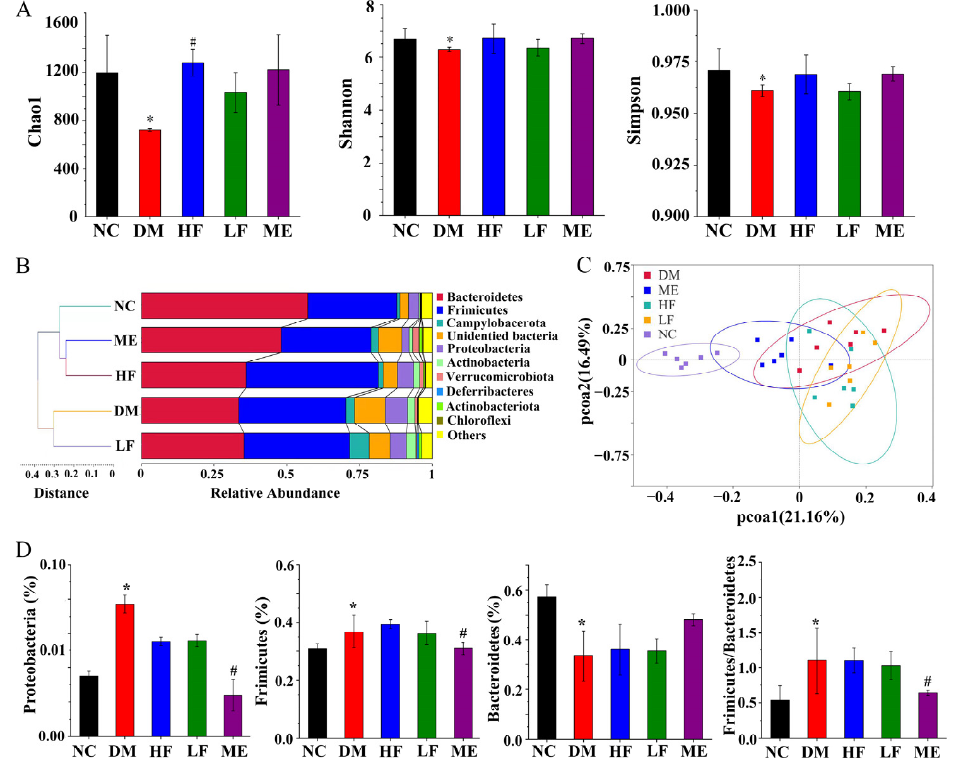
Figure 6. Effect of LJF on the gut microbiota: Chao1, Shannon, and Simpson indexes ( A ); UPGMA ( B ); PCoA ( C ); relative abundances of Proteobacteria, Firmicutes, Bacteroidetes, and the ratio of Firmicutes to Bacteroidetes at the phylum level ( D ). * p < 0.05 vs. NC group, and # p < 0.05 vs. DM group.